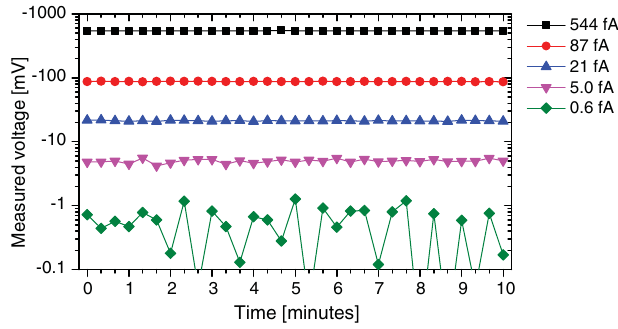
FIG. 21. Beam-current measurements at 10 12 V = A transimpe- dance gain for various proton beam intensities at INFN-LNS. Each point is averaged over 20